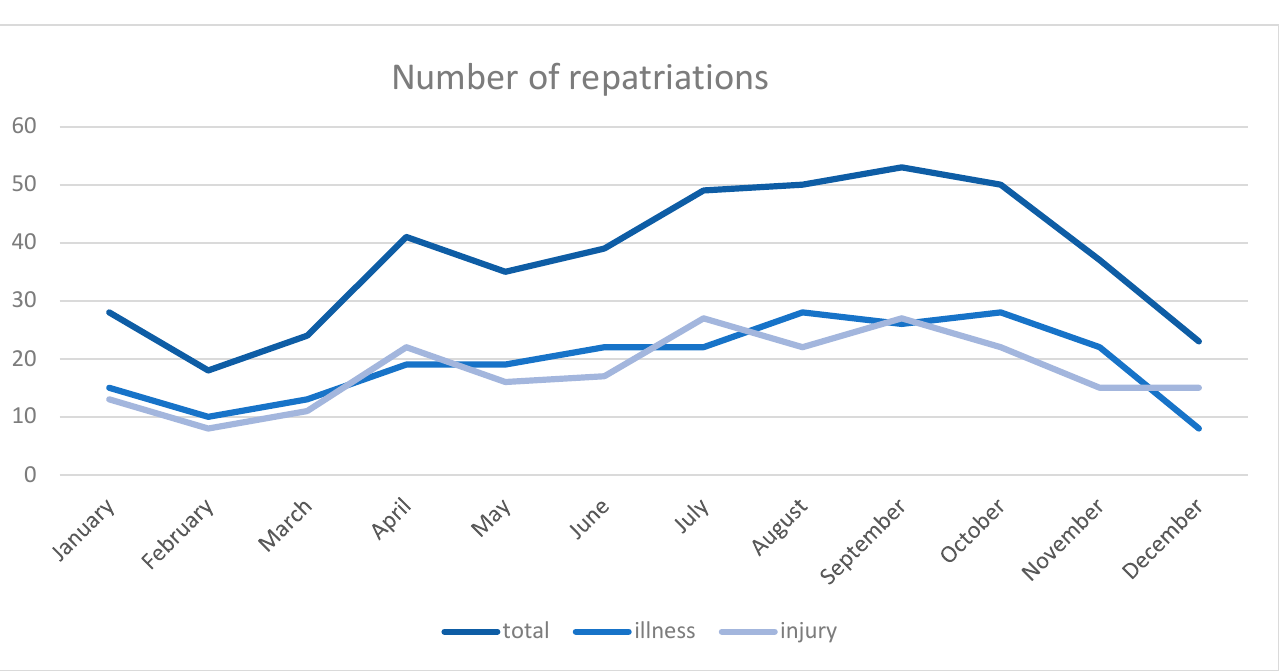
Table 1. Overview results.